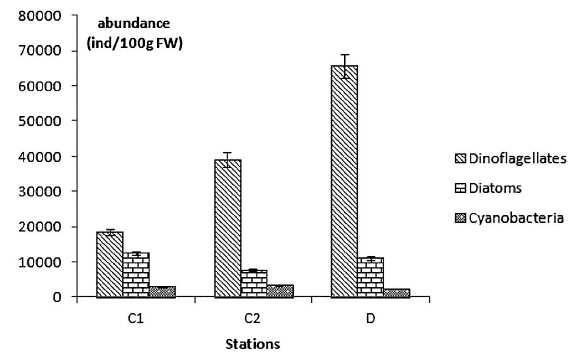
Fig. 3. – Average abundance of microepiphytes on leaves at pros- pected stations.